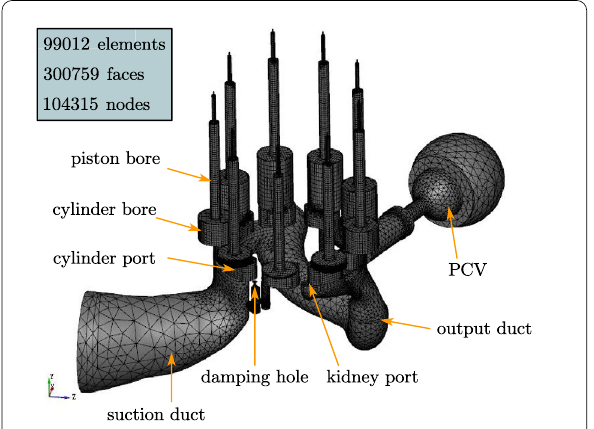
Figure 2 Mesh result of the fluid field of the axial piston